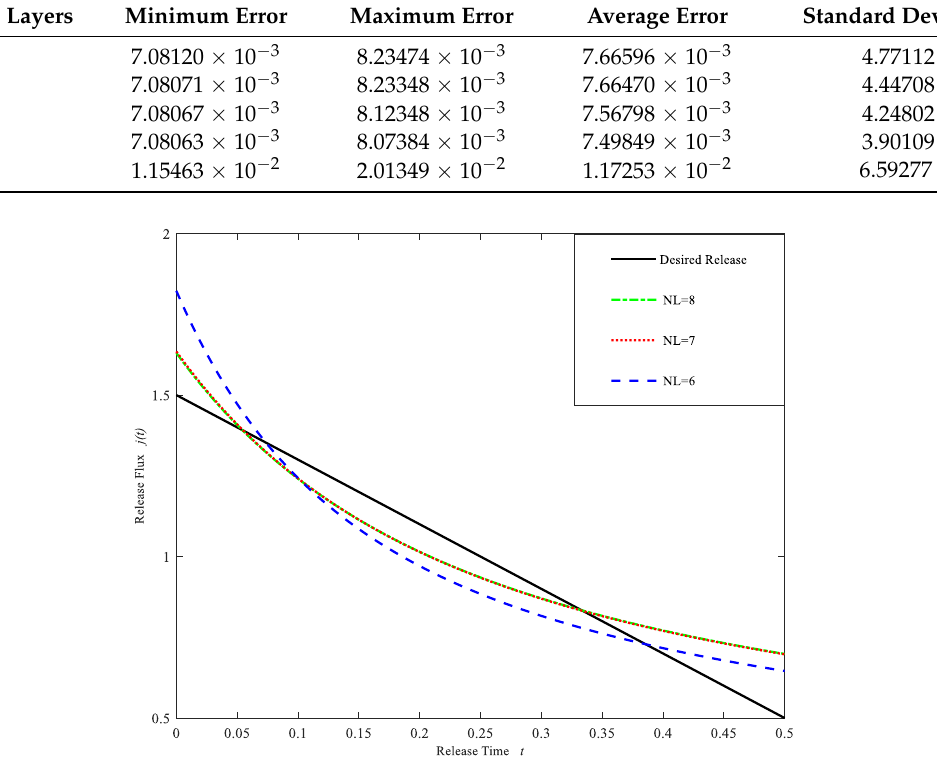
Table 8. The initial drug concentration and diffusion coefficient at each layer of the drug- controlled release model for NL = 8 (Case 1).